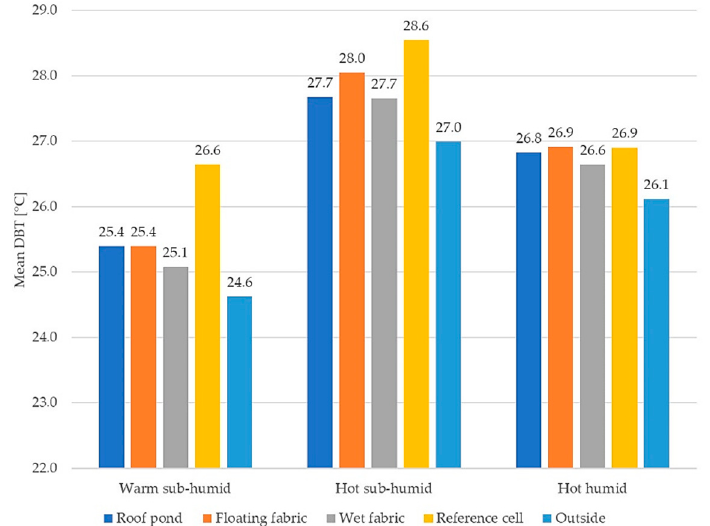
Figure 16. Mean DBT of all cases in the three climatic conditions.